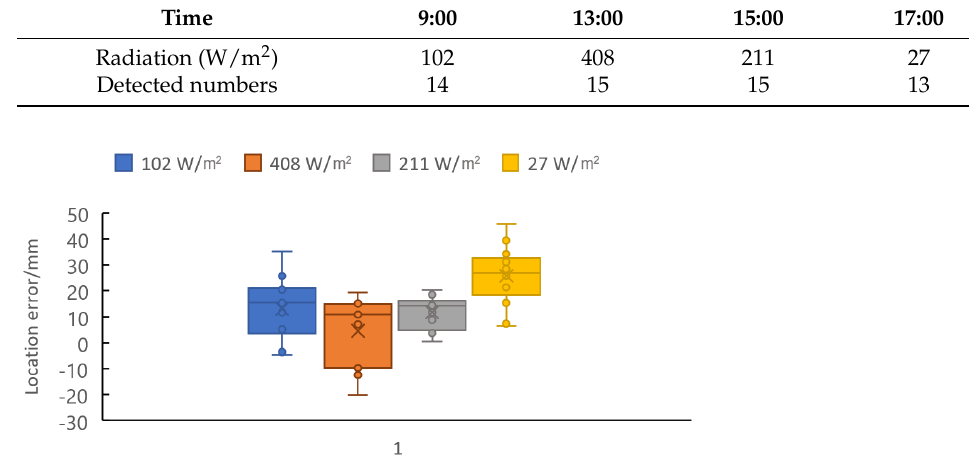
Figure 11. The location results in varying levels of radiation at a different time on a sunny day in the